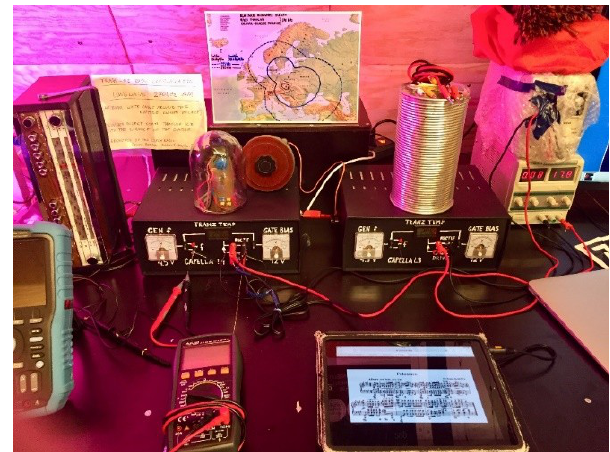
Figure 12. Both IGLUNA 2019 longwave transmitters inside the simulated lunar habitat in the Glacier Paradise, 3868 m a. s. l. The modulation (acoustic) signal is generated directly by a tablet for the ‘glass dome’ transmitter and by an STM32-based microcontroller circuit for the ‘Thermos’ transmitter. The Jowita 2 radio receiver for on-site modulation control can be seen on the left. The pink glow of the stand is created by one of the nearby experiments. The map above the transmitters shows the signal coverage of 225 kHz (Solec Kujawski) and 270 kHz (Topolná) for comparison. Photograph by the Author.